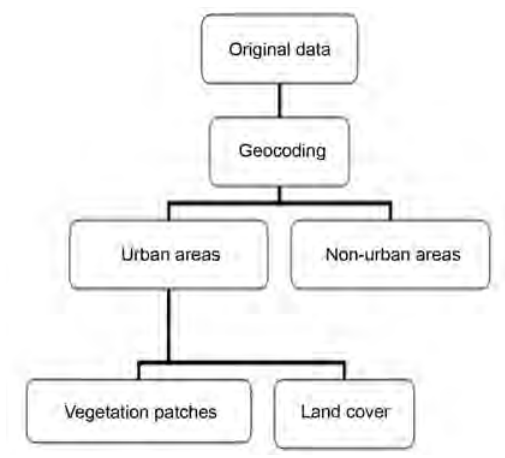
Fig. 1. The work flow of the research presented in this